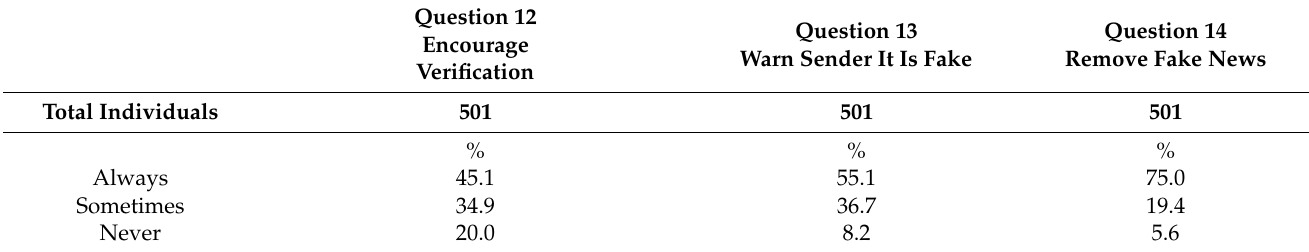
Table 16. Question 12: Do you encourage your contacts/friends/family to share information only if they have verified it? Question 13: When you receive a news item and you realize that it is or may be fake news, do you tell the person who